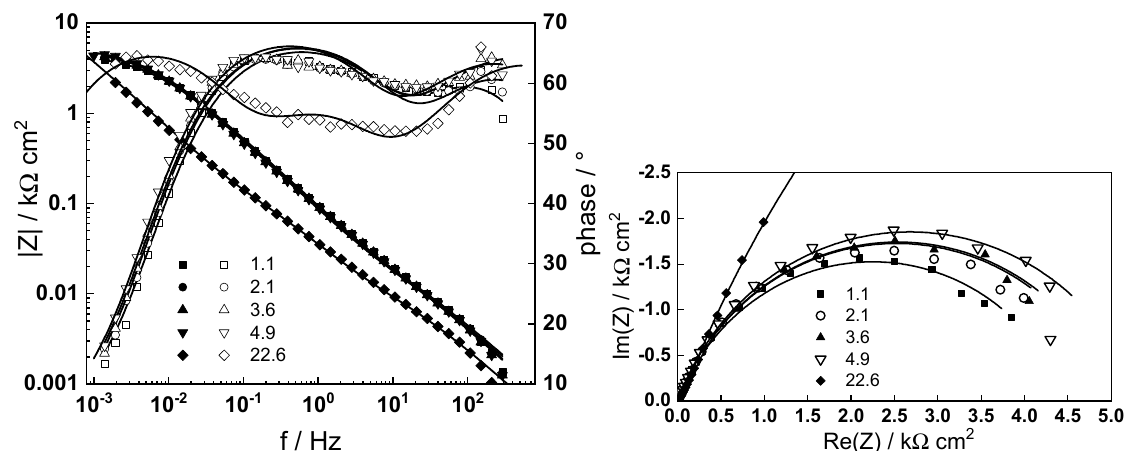
Figure 3. Electrochemical impedance spectra of AISI 316L at 130 ° С in AMETA water chemistry in the absence of magnetite particles. ( left )—impedance magnitude (full symbols) and phase shift (open symbols) vs. frequency, ( right )—complex plane representation. Points—experimental data, solid lines—best-fit calculation with respect to the MCM equations discussed in the text. The legend is oxidation time (h).